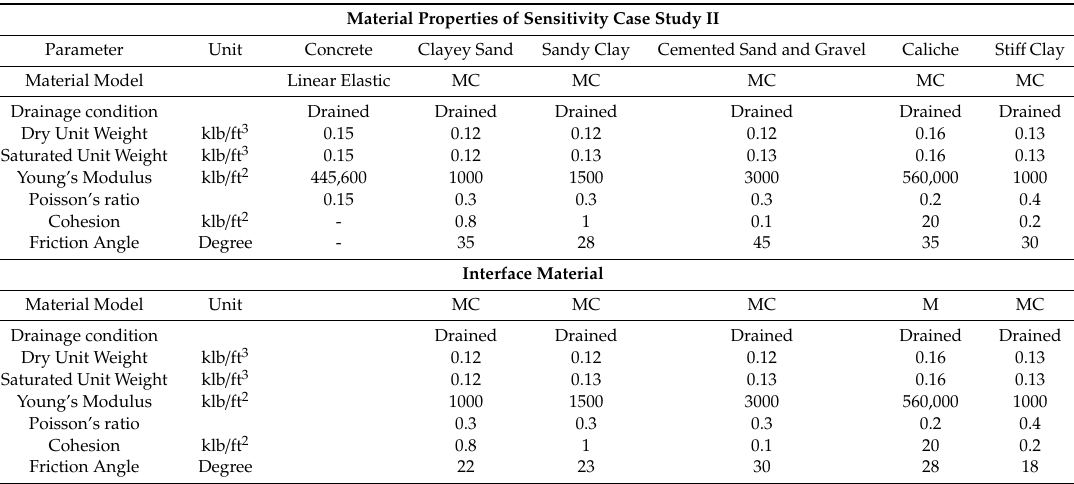
Table 3. Material Properties, Case Study